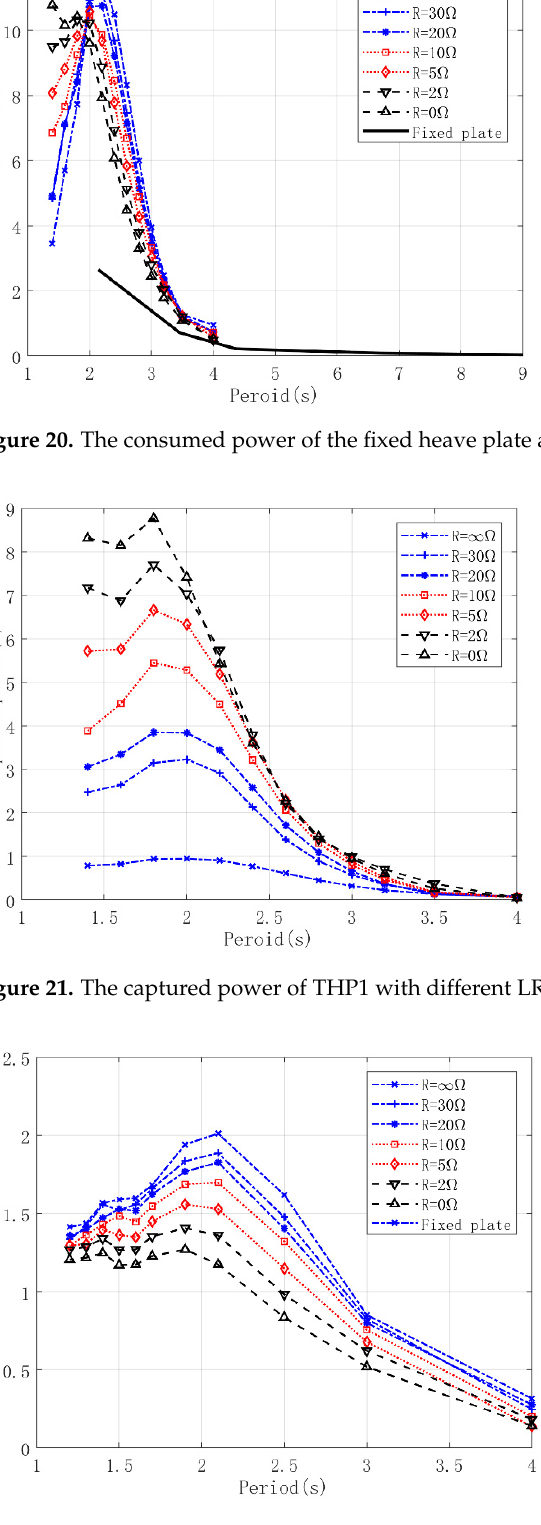
Figure 23. The captured energy ratio of THP1 with different tuned periods and LRs. 5. Conclusions